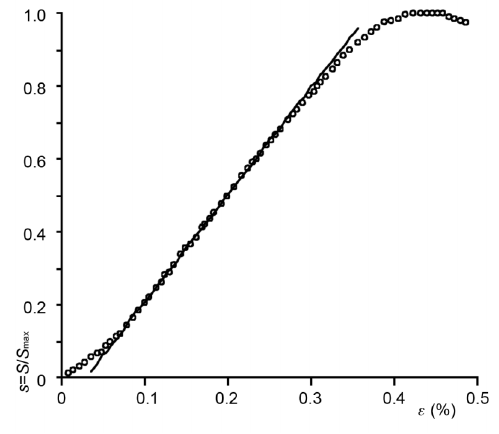
Fig. 1. Typical marble stress-strain curve on nor- malised stress axis.